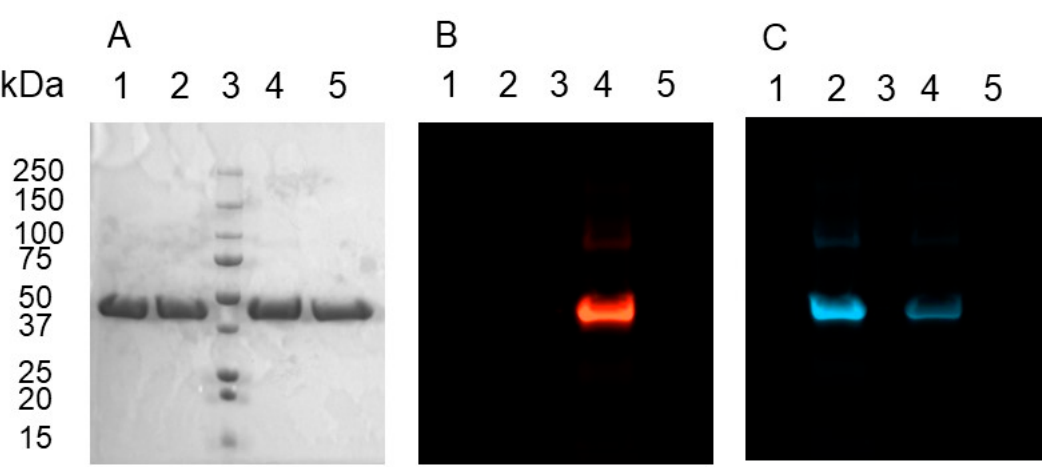
Figure 4. SDS PAGE gel of protein conjugates obtained after first reacting 10 µ M 15 with 10 µ M MBP-dC10*, followed by the conjugation of rhodamine B azide (RhB-N 3 ) to MBP-dC10* through 15 using CuAAC. ( A ) Coomassie stained gel showing MBP-dC10* bands. ( B ) Unstained gel imaged using a 605 / 50 filter. ( C ) Unstained gel excited with Blue Epi Illumination and imaged with a 530 / 28 filter. Lanes: (1) MBP-dC10* (2) MBP-dC10* reacted with 15 (3) pre-stained protein molecular weight markers